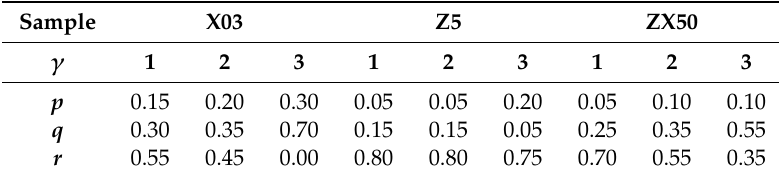
Table 5. Parameters p , q and r of the proposed apatite–phosphate–hydroxide model for di ff erent types of phosphate. Sample